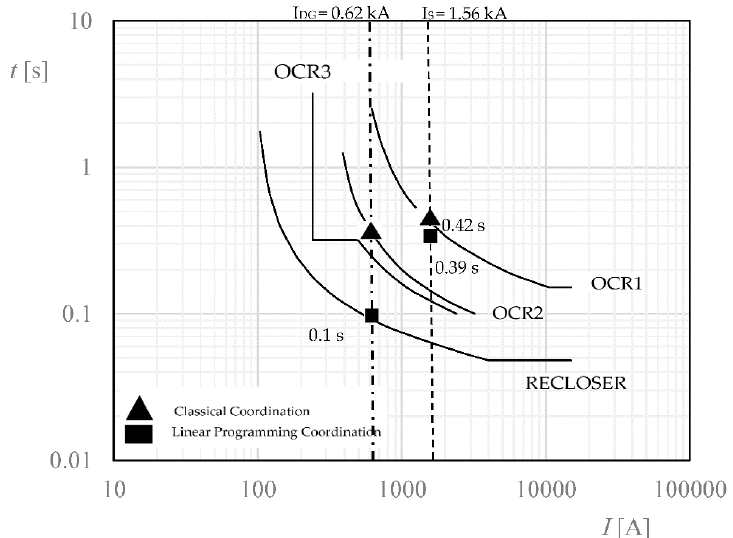
Figure 9. Short-circuit in F2 with penetration level of DG1 17 %. Classical coordination versus linear programming coordination.